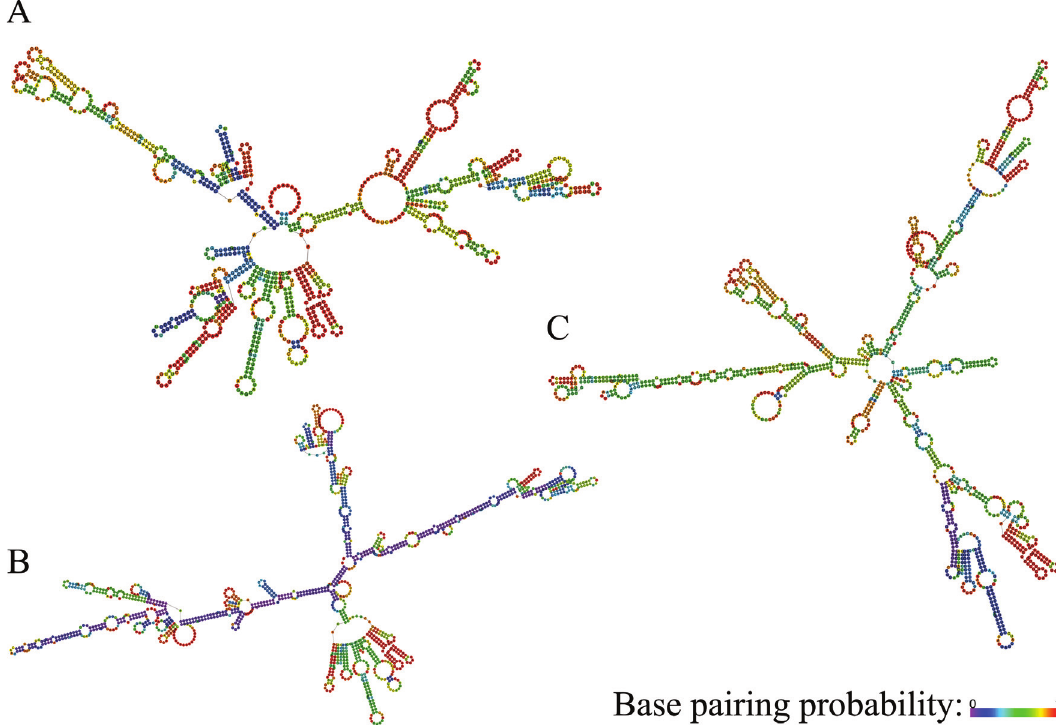
Figure 1 - Folding patterns of GPX2 transcript variants. A - transcript variant 1 (protein-coding); B - transcript variant 2 (NMD); C - transcript variant 3 (NMD). Color-scale represents base pairing probabilities: violet and red correspond to 0 and 1 probabilities, respectively.